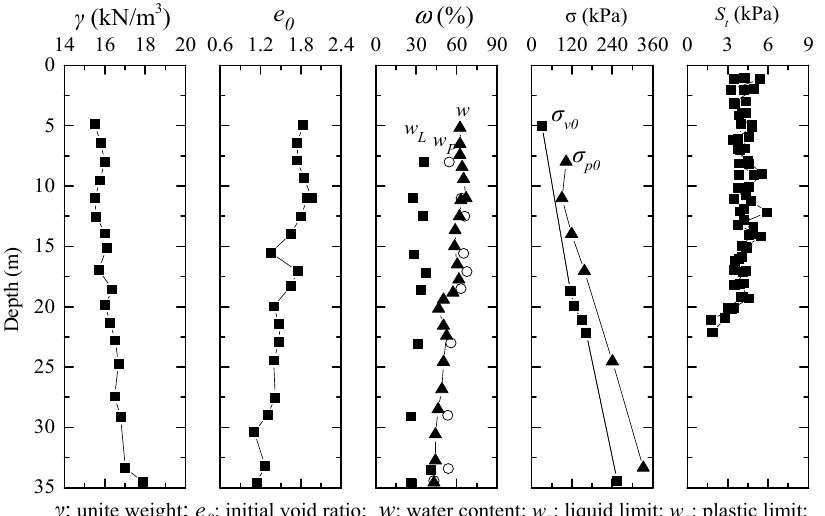
Figure 6. Physical properties of Wenzhou Clay.